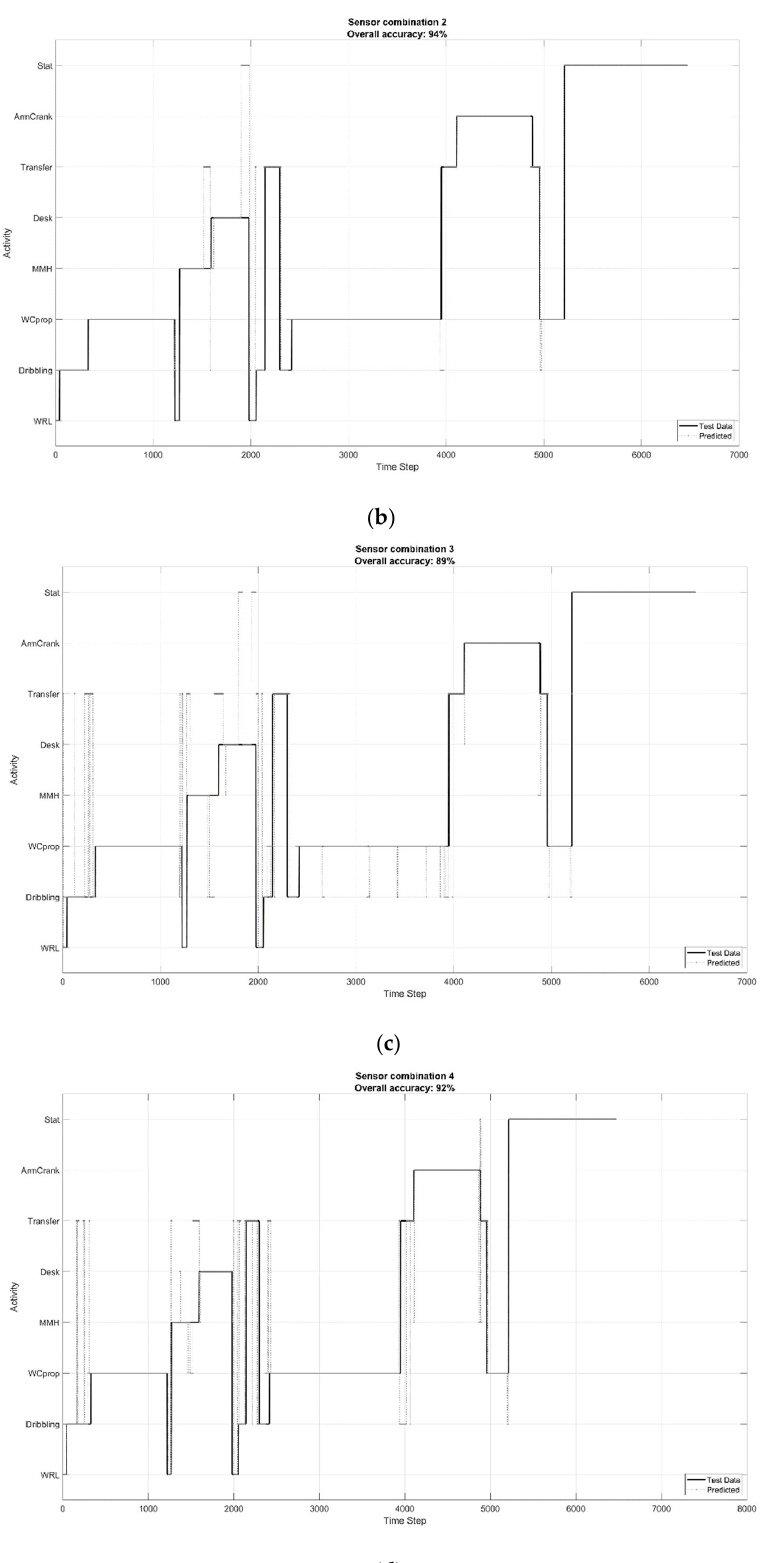
Figure 6. The time lines of predicted (dashed lines) versus test data (solid line) for one participant, for sensor combinations 1–4, indicated by ( a – d ) respectively).